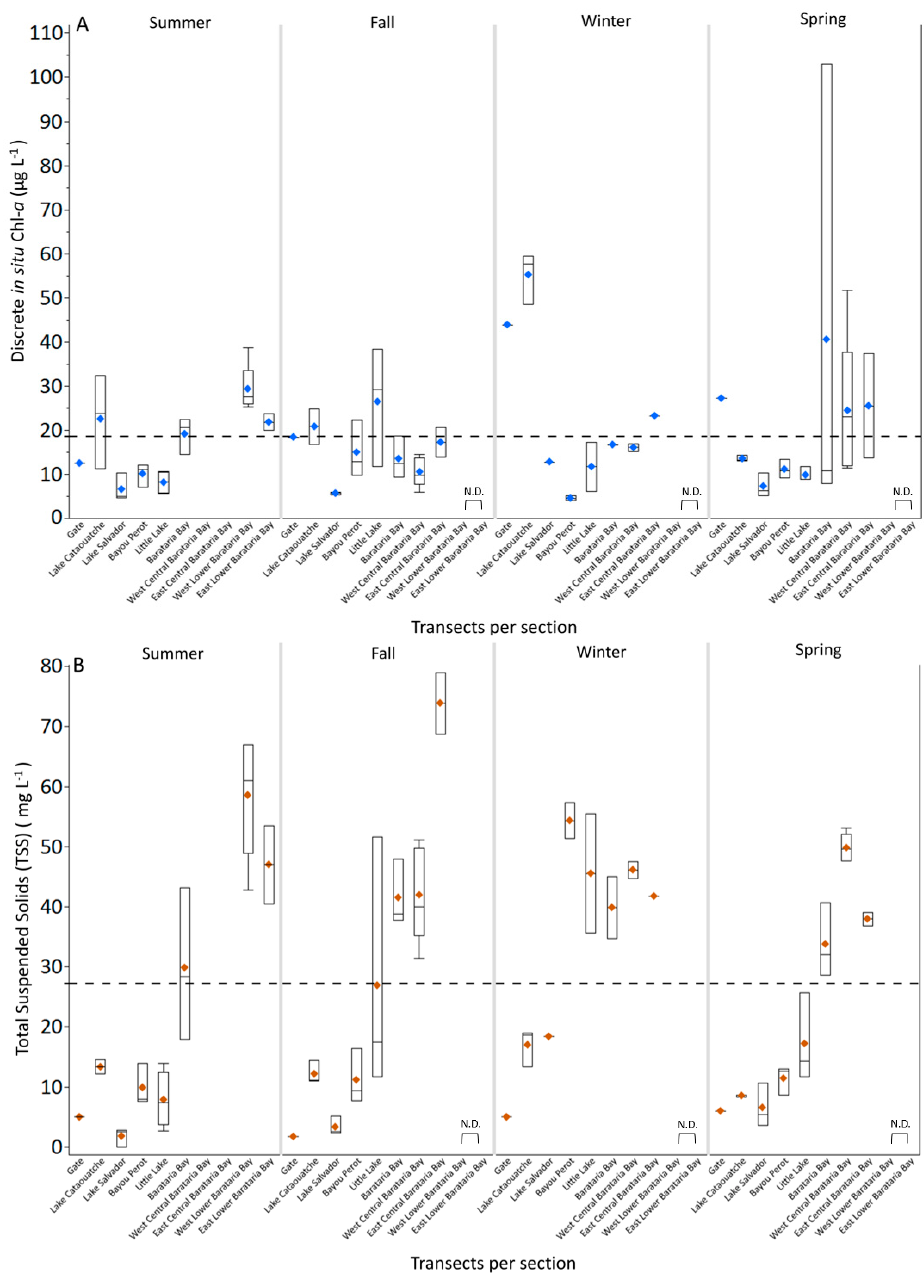
Figure 3. Box plots of ( A ) seasonal discrete Chl- a concentration obtained by 90% acetone extraction method (EPA 445.0-2) and ( B ) Total suspended solids (TSS) values during the Mississippi River flood pulse in 2019–2020. Dashed line indicates the average in situ [Chl- a ] and [TSS] during the sampling period. Blue [Chl- a ] and brown [TSS] diamonds are the seasonal averages per transect section: summer (9 July 2019), fall (13 September 2019), winter (14 December 2019) and spring (30 May 2020). N.D. = no